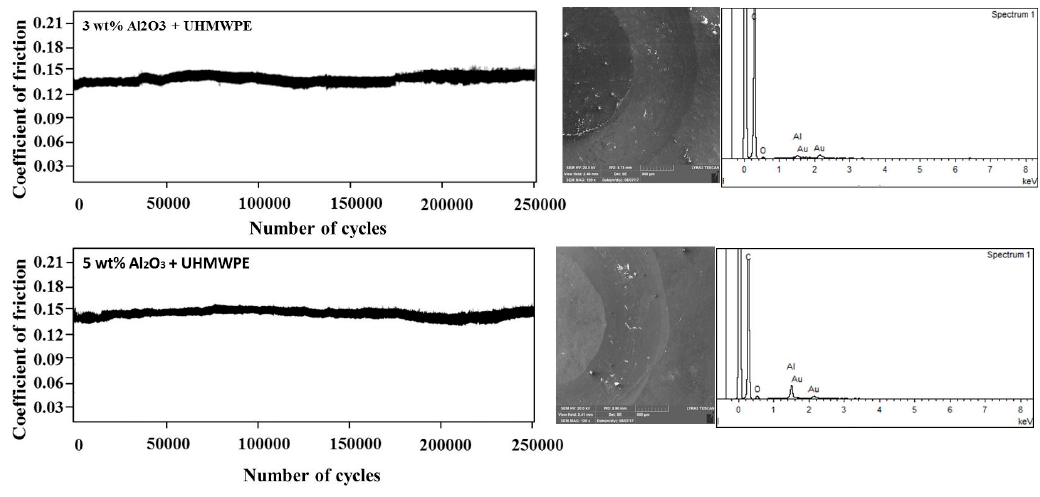
Figure 10. Typical frictional graphs, FESEM/EDS spectrums of the wear track after a sliding wear test of 250,000 cycles conducted on nanocomposite coatings with different loadings, 3 and 5 wt % of alumina, respectively, at a normal load of 12 N and at a sliding speed of 0.1 m/s.